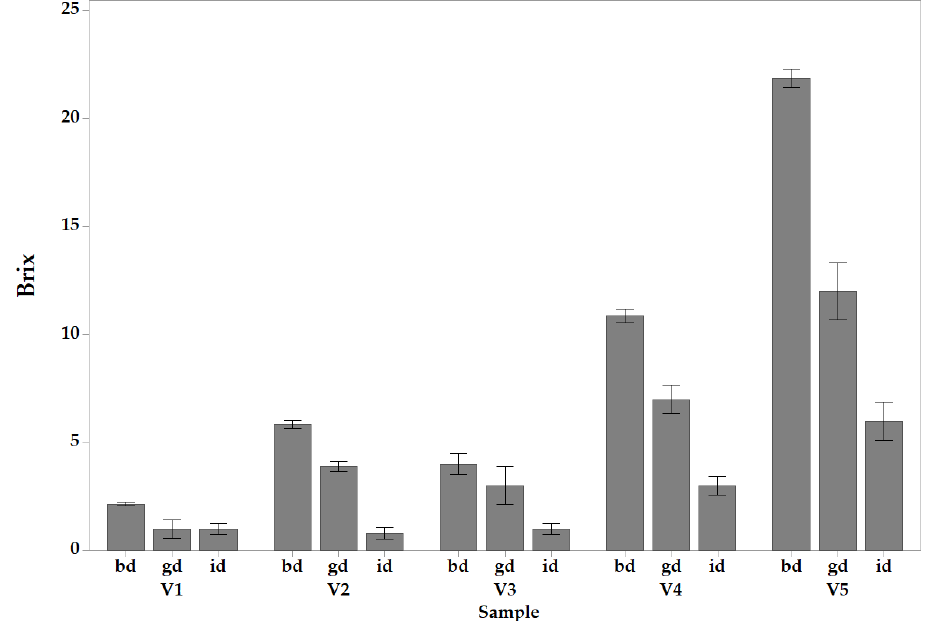
Figure 5. Interval plots of Brix vs. samples before digestion (bd); and after gastric digestion (gd); intestinal digestion (id). V1 = banana peel vinegar aged for 1 year, produced without boiling the peels boiling aged for 1 year, V2 = banana peel vinegar aged for 3 years, produced without boiling the peels boiling aged for 3 years, V3 = banana peel vinegar aged for 2 years, produced with peels boiling the peels aged for 2 years, V4 = commercial balsamic vinegar produced from concentrated apple juice and caramel aged in oak barrels for 1 year, V5 = Modena commercial vinegar obtained from concentrated grape must. The error bars represent a 95% confidence interval for the mean.